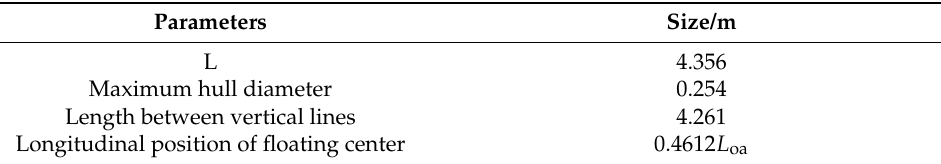
Figure 5. Full-body SUBOFF geometric model. Table 2. Table of main elements of fully attached Table 2. Table of main elements of fully attached SUBOFF.